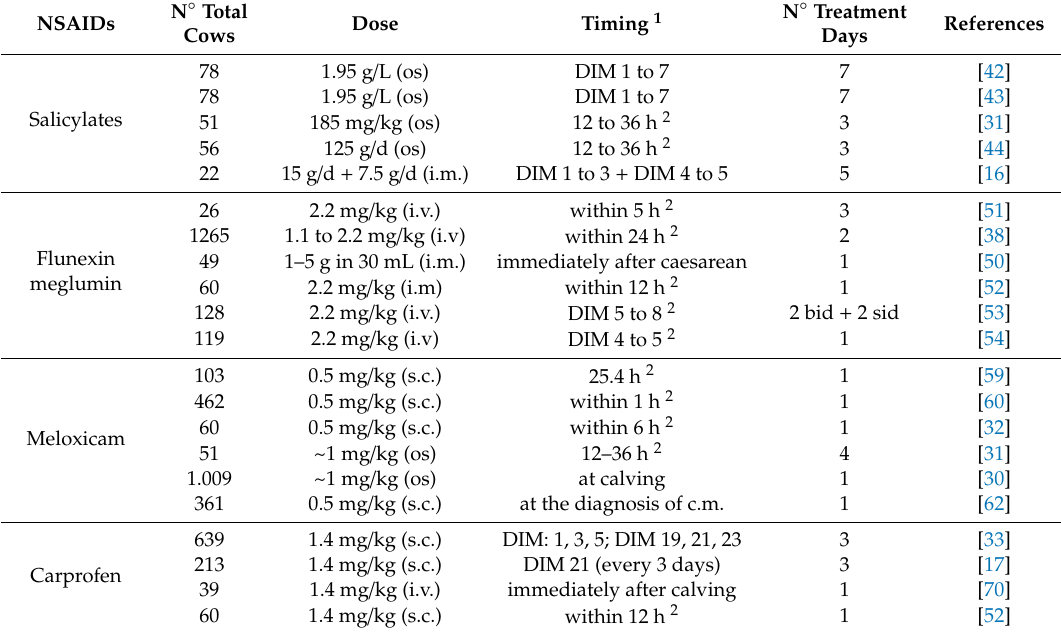
Table 2. Summary of studies in periparturient dairy cows reporting doses and timing of treatments with commonly-used nonsteroidal anti-inflammatory drugs (NSAIDs) investigated during the periparturient period of dairy